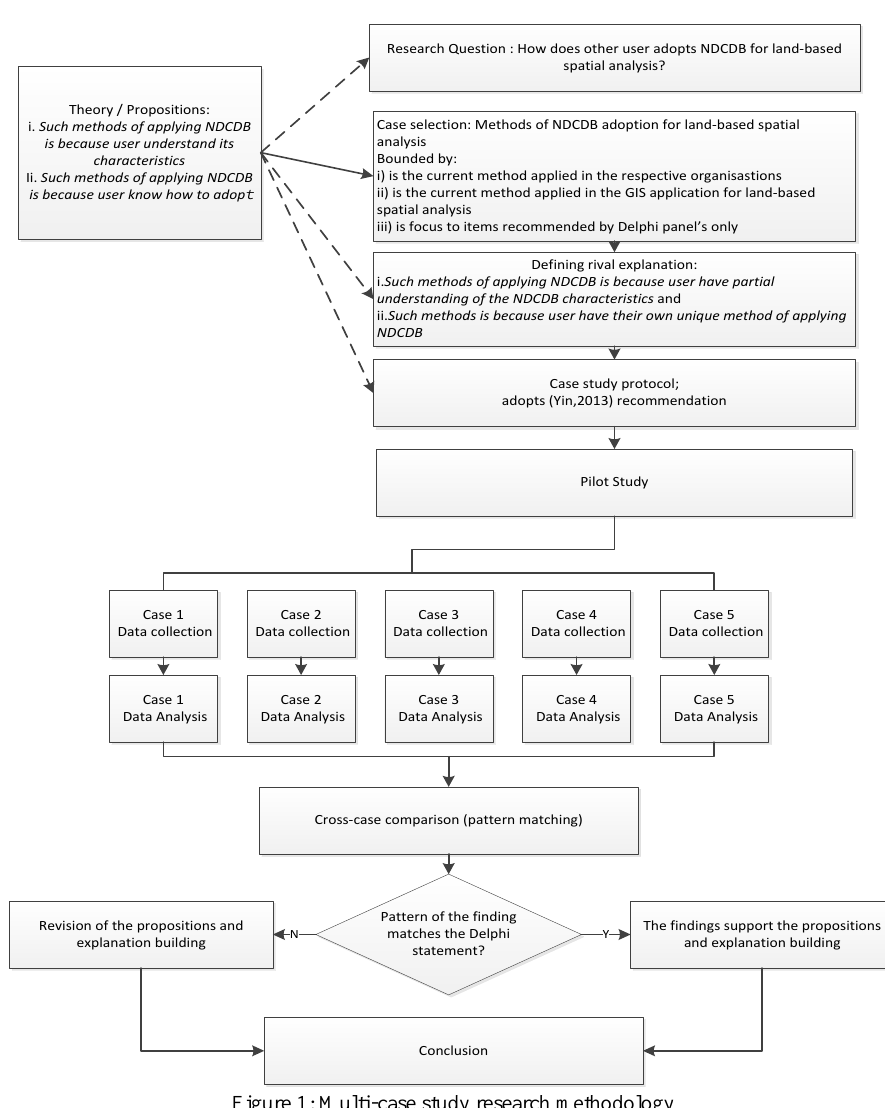
Figure 1: Multi-case study research